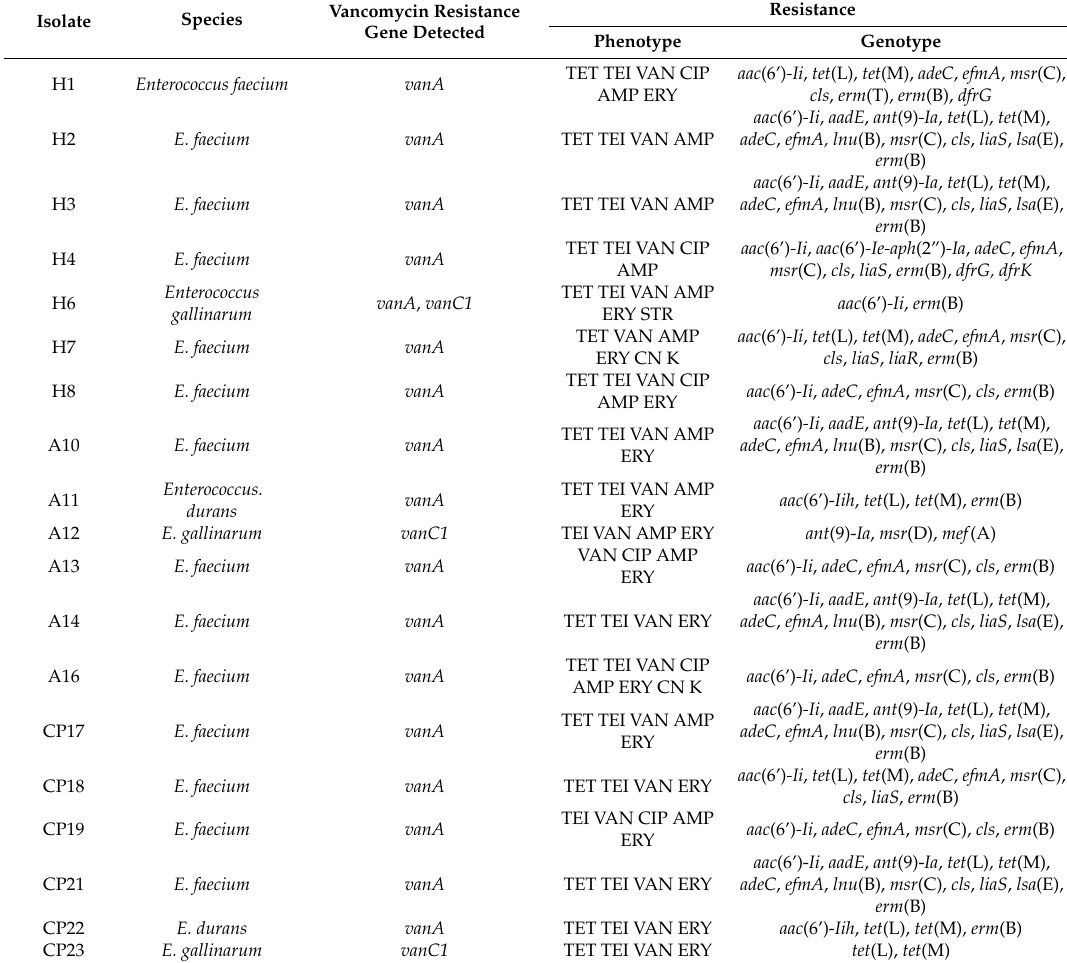
Table 1. Characteristics of the Nineteen Vancomycin-Resistant Enterococci Isolates Recovered from Processed